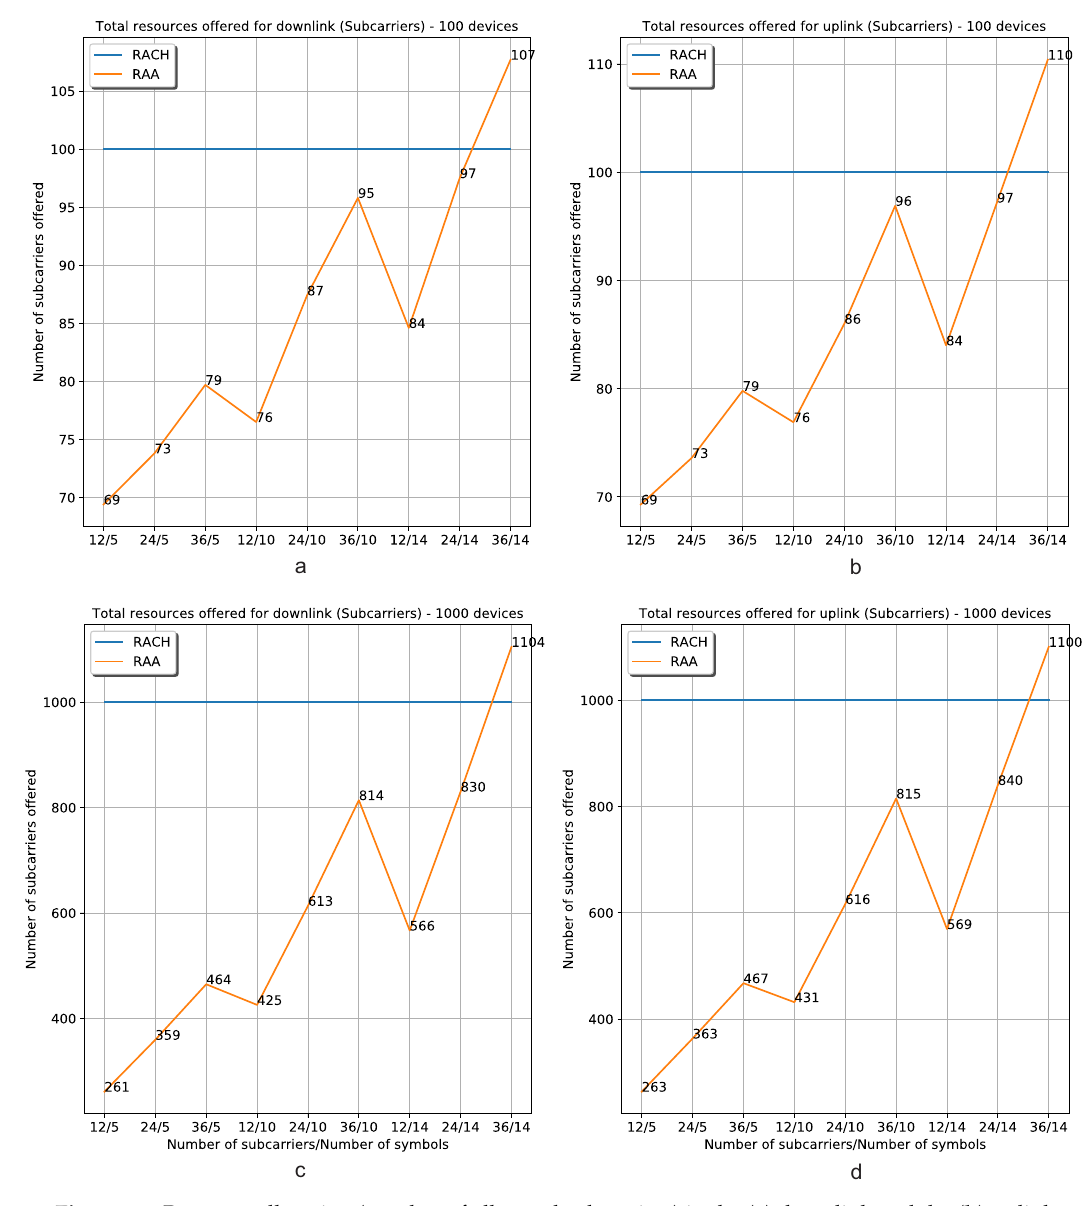
Figure 10. Resource allocation (number of allocated subcarriers) in the ( a ) downlink and the ( b ) uplink when there are 100 devices registered, and resource allocation in the ( c ) downlink and ( d ) uplink when there are 1000 devices connected to the mobile network using the classic resource allocation procedure (the result of RACH execution) and the RAA